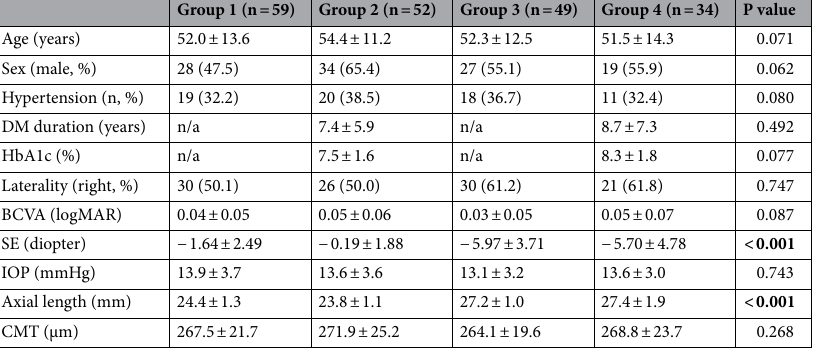
Table 1. Demographics and clinical characteristics of each group. DM diabetes mellitus, BCVA best-corrected visual acuity, SE spherical equivalent, IOP intraocular pressure, CMT central macular thickness. All values are expressed as the mean ± standard deviation. Values in boldface (P < 0.050) are statistically